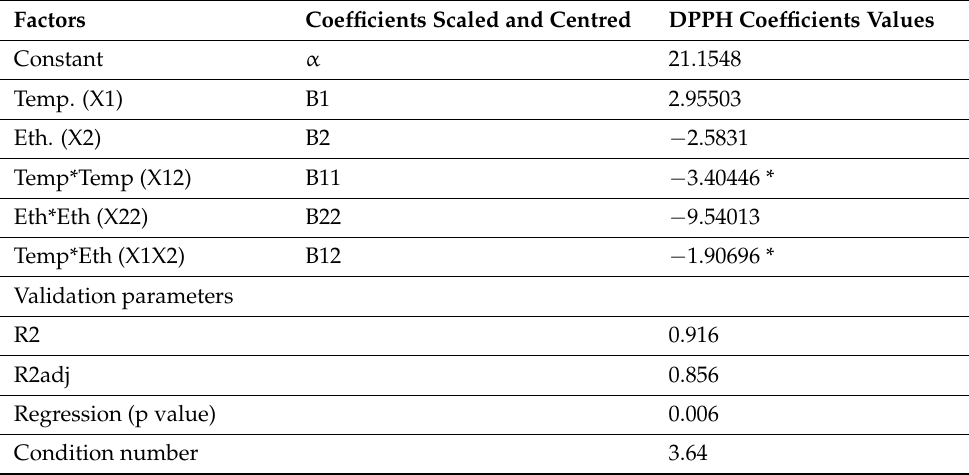
Table 6. DPPH Statistical parameters of the model